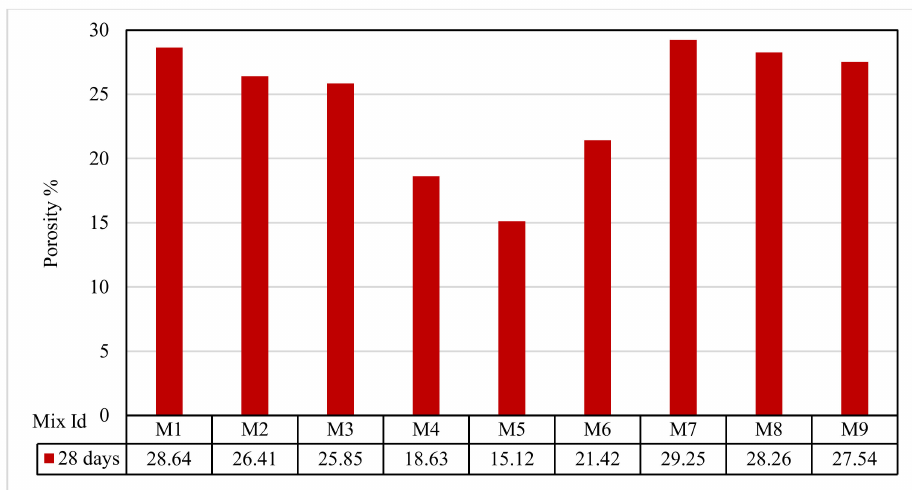
Figure 12. The porosity test results.